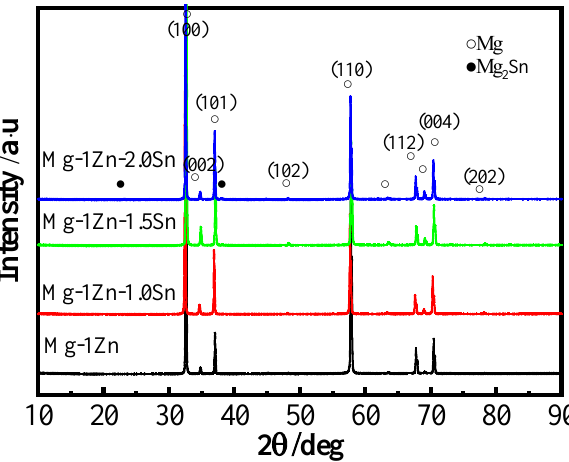
Figure 2. XRD patterns of Mg-1Zn-xSn ternary alloys.